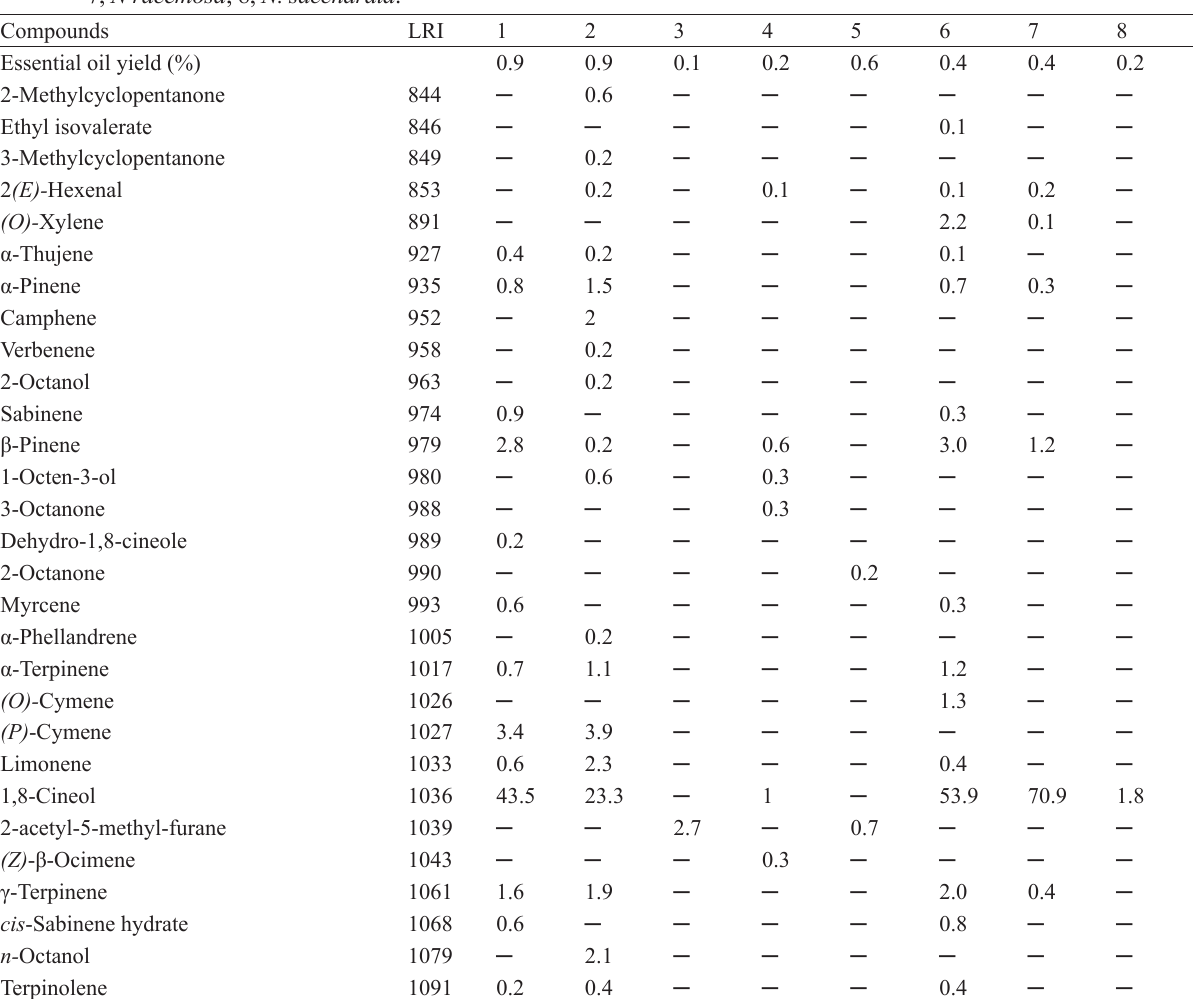
Table 2. Percentages of chemical compositions of the essential oil among the studied taxa. Abbreviations are: LRI, Determined linear retention index against mixture of n-alkanes (C8-C31) on HP-5 column; Nepeta analyzed are: 1, N. binaludensis ; 2, N. glomerulosa var. carmanica ; 3, N. kotschyi var. persica (%); 4, N. meyeri ; 5, N. mirzayanii ; 6, N. pogonosperma